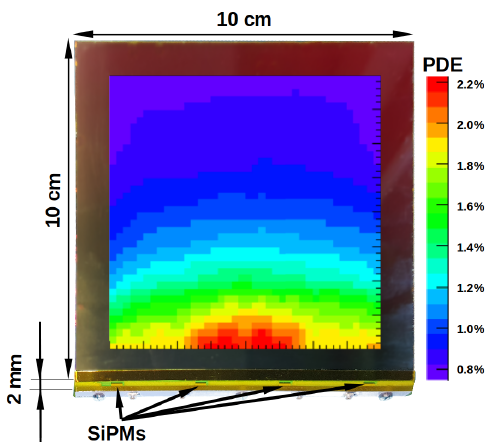
Figure 8. ArCLight measured photon detection efficiency (PDE) map overlaid onto the 10 × 10 cm 2 surface of the detector. Color scale is shown in % units. Increase in PDE near SiPM side is due to increased fraction of direct photons, avoiding initial loss at first reflection from the dichroic mirror. Short component of WLS bulk attenuation is likely contributing to this direct access as